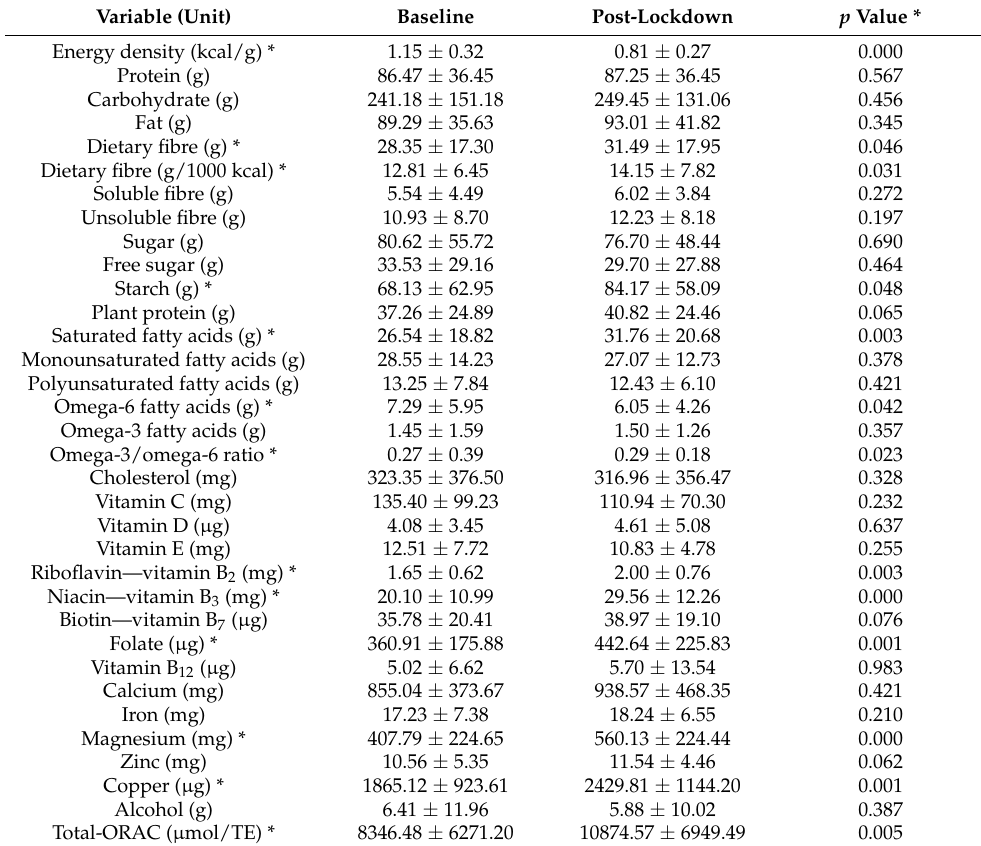
Table 4. Energy, Macronutrient and Micronutrient Intake from Diet at Baseline and Post-Lockdown.